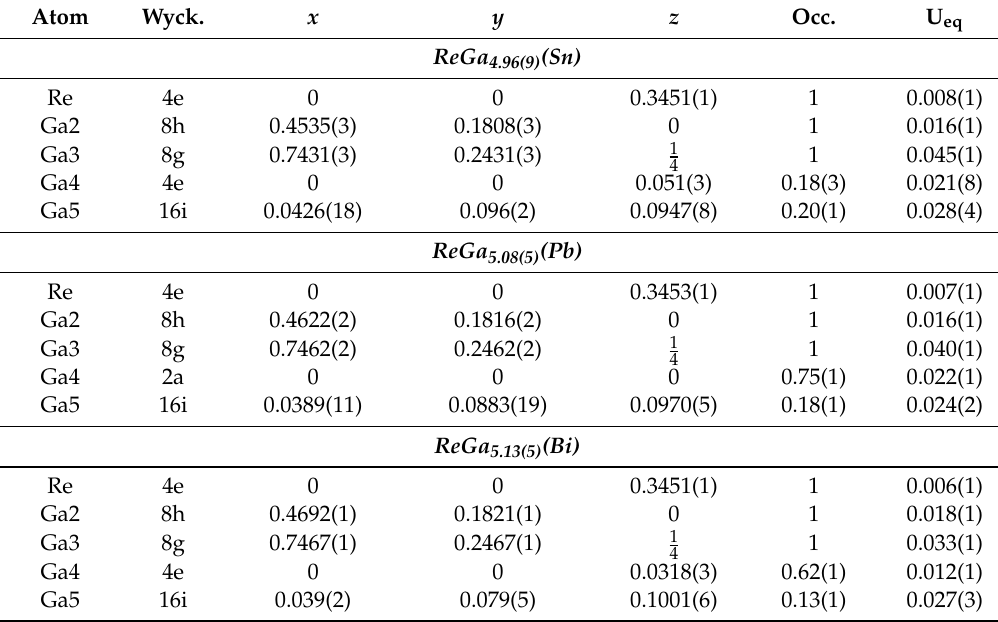
Table 2. Atomic coordinates and equivalent isotropic displacement parameters for ReGa 4.96 (Sn), ReGa 5.08 (Pb) and ReGa 5.13 (Bi) (U eq is defined as one-third of the trace of the orthogonalized U ij tensor (Å 2 )).